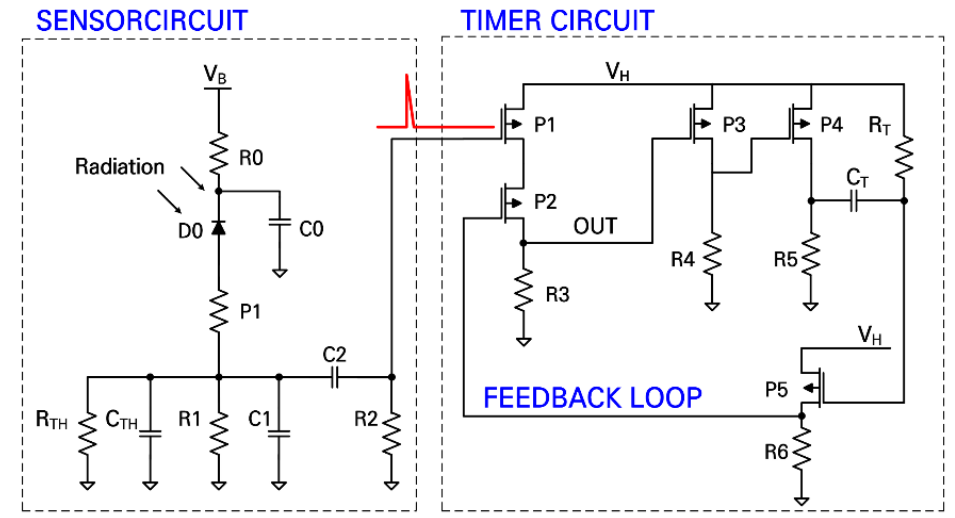
Figure 10. Switching-based pulsed-radiation detection circuit that only contains p-MOSFETs.